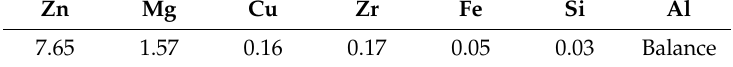
Figure 8. Transmission electron microscopy (TEM) microstructures of specimens deformed under different parameters. ( a ) 500 °C /0.01 s − 1 (ln Z = 20.9); ( b ) 450 °C /1 s − 1 (ln Z = 27.3).